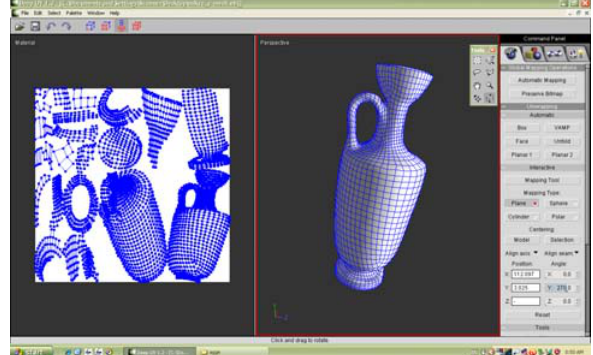
Fig. 7. Automated creation of UV-map (2D texture map) through the algorithms of the DeepUV software